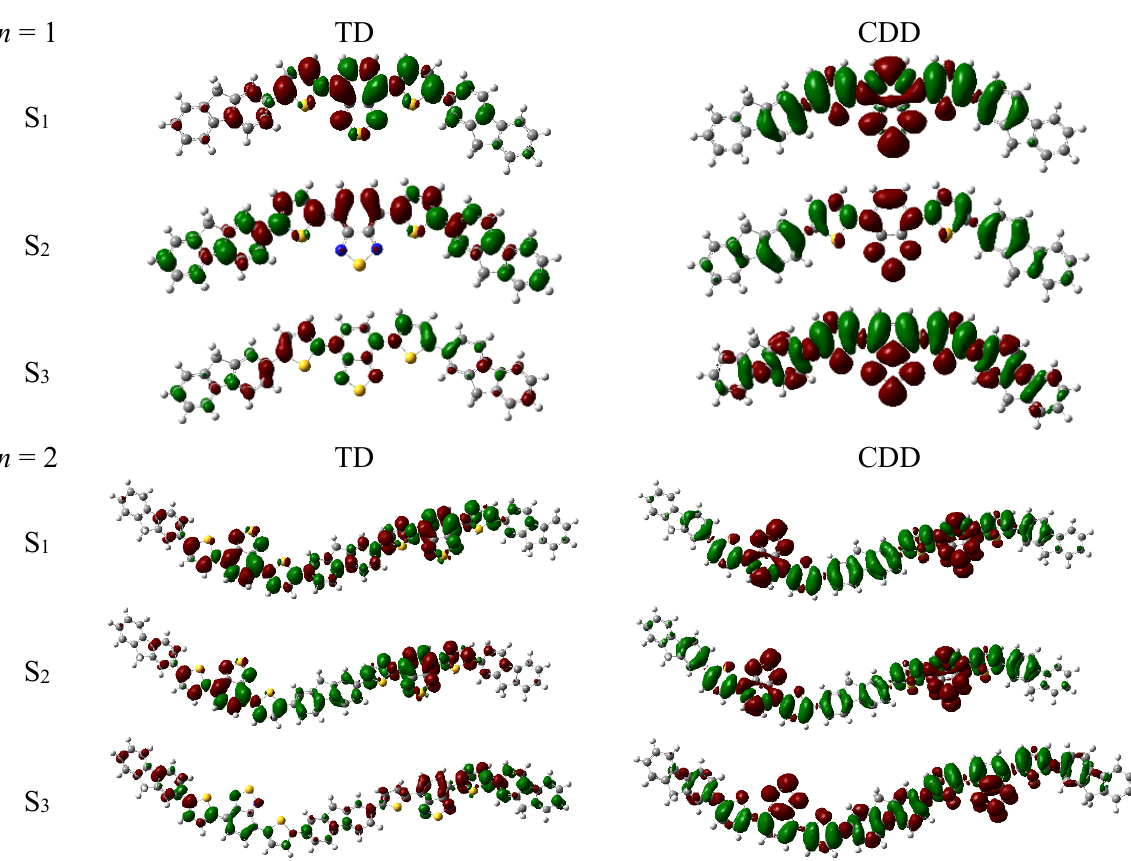
Figure 3. Transition density (TD) and charge difference density (CDD) of polymer ( n = 1 and n = 2).